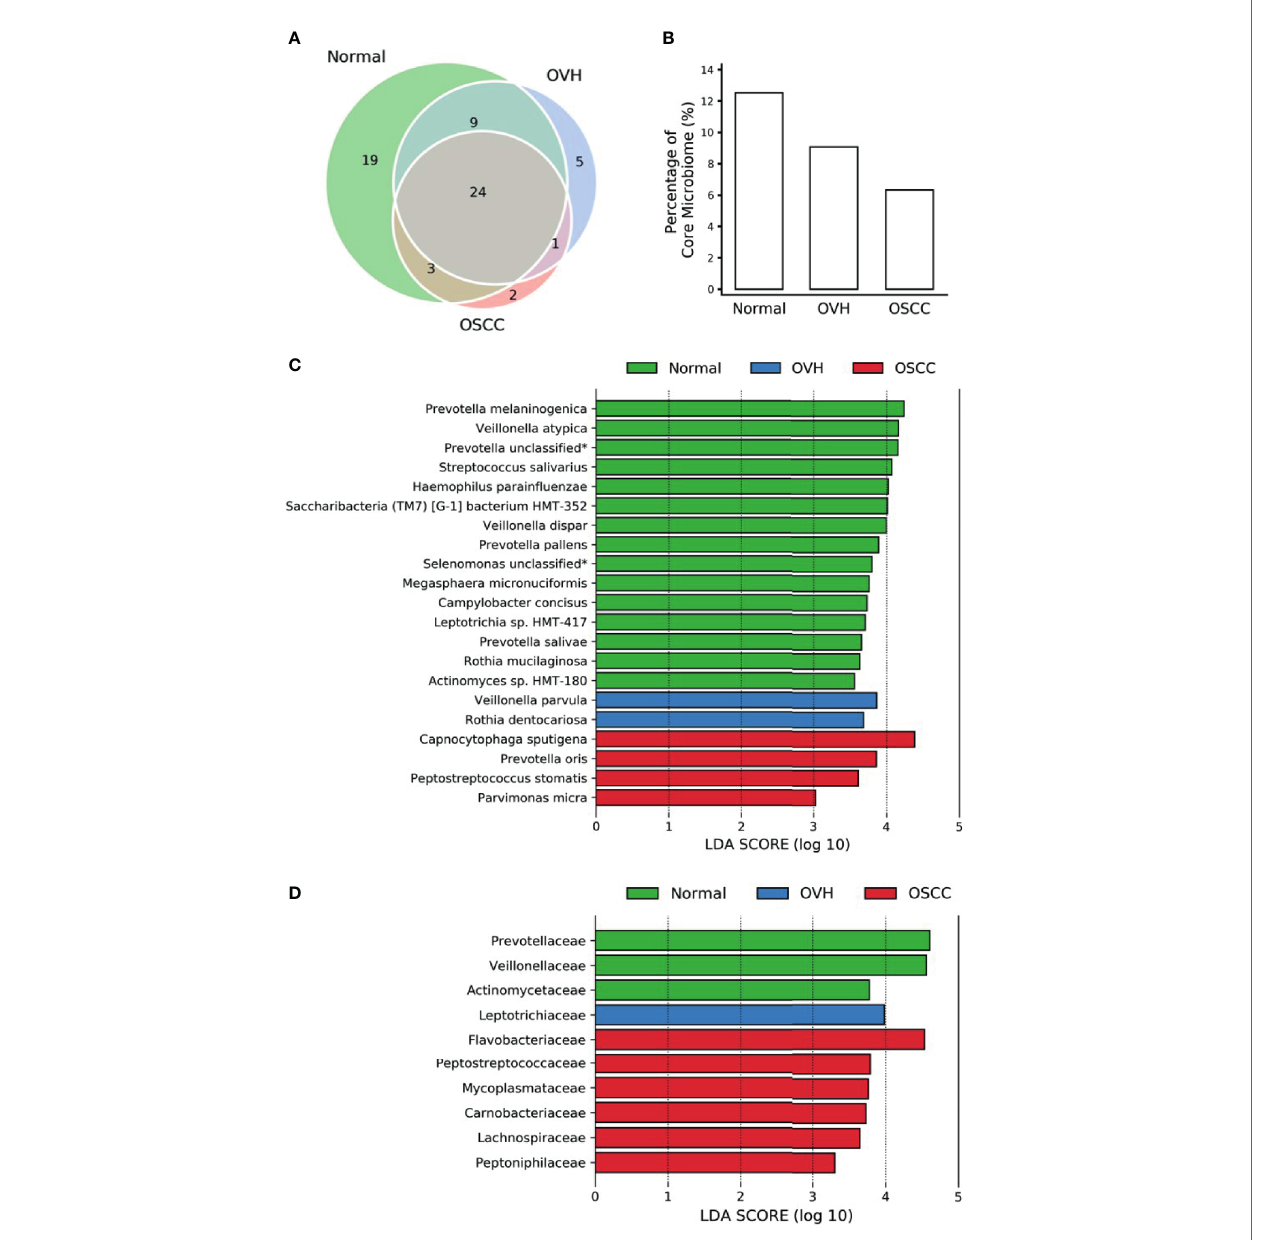
FIGURE 2 | Core microbiome analysis. (A) Venn diagram of core microbiomes among cohorts. The core is de fi ned as the species taxa present in saliva with ≥ 75% prevalence. (B) The fraction of core species number to overall species richness in each cohort. (C) LEfSe reveals the distribution of core species displaying the abundance signi fi cantly higher (LDA > log10 3 ) among cohorts. The asterisk (*) indicates a taxon that was annotated only to the genus level. (D) Same as (C) but at the family